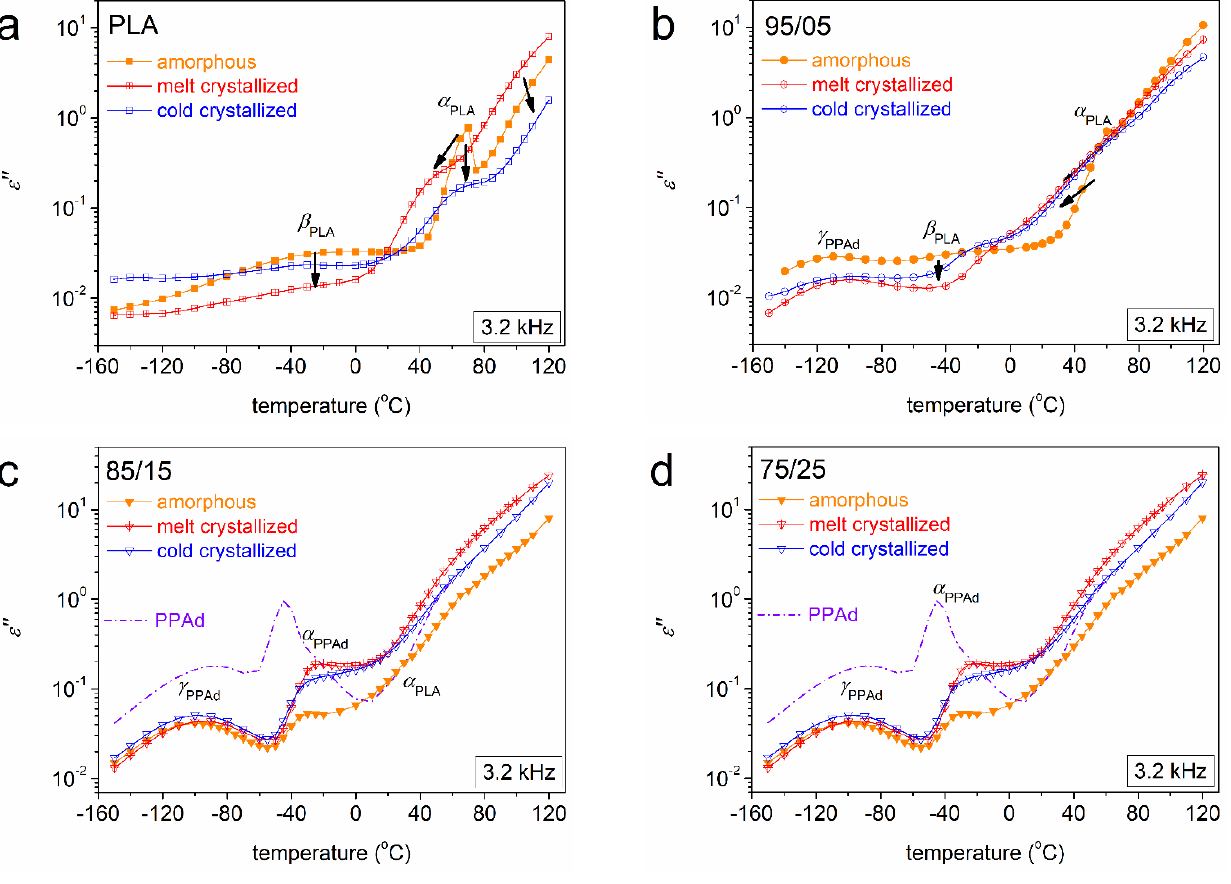
Figure 11. Comparative isochronal ε″ ( T ) plots at f ~ 3.2 kHz for ( a ) PLA, ( b ) 95/05, ( c ) 85/15 and ( d ) 75/25, showing the effects on relaxation processes from the amorphous state (solid symbols) to the semicrystalline state (crossed and open symbols). For comparison, we added in the ε″ ( T ) plot at f ~ 3.2 kHz for initial PPAd in ( c ) and ( d ). The added arrows mark the crystallinity-imposed effects.